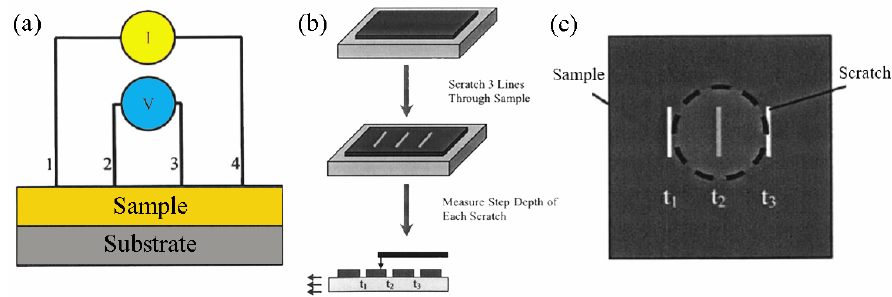
Figure 4. ( a ) Four-point electrical conductivity circuit. Current is supplied between pin 1 to pin 4, while voltage is measured between pin 2 to pin 3; ( b ) The process and locations of thickness measurements using the profilometer; and ( c ) The electrical conductivity measurement area of the sample. Reproduced from [99] with permission; Copyright Massachusetts Institute of Technology 2013.